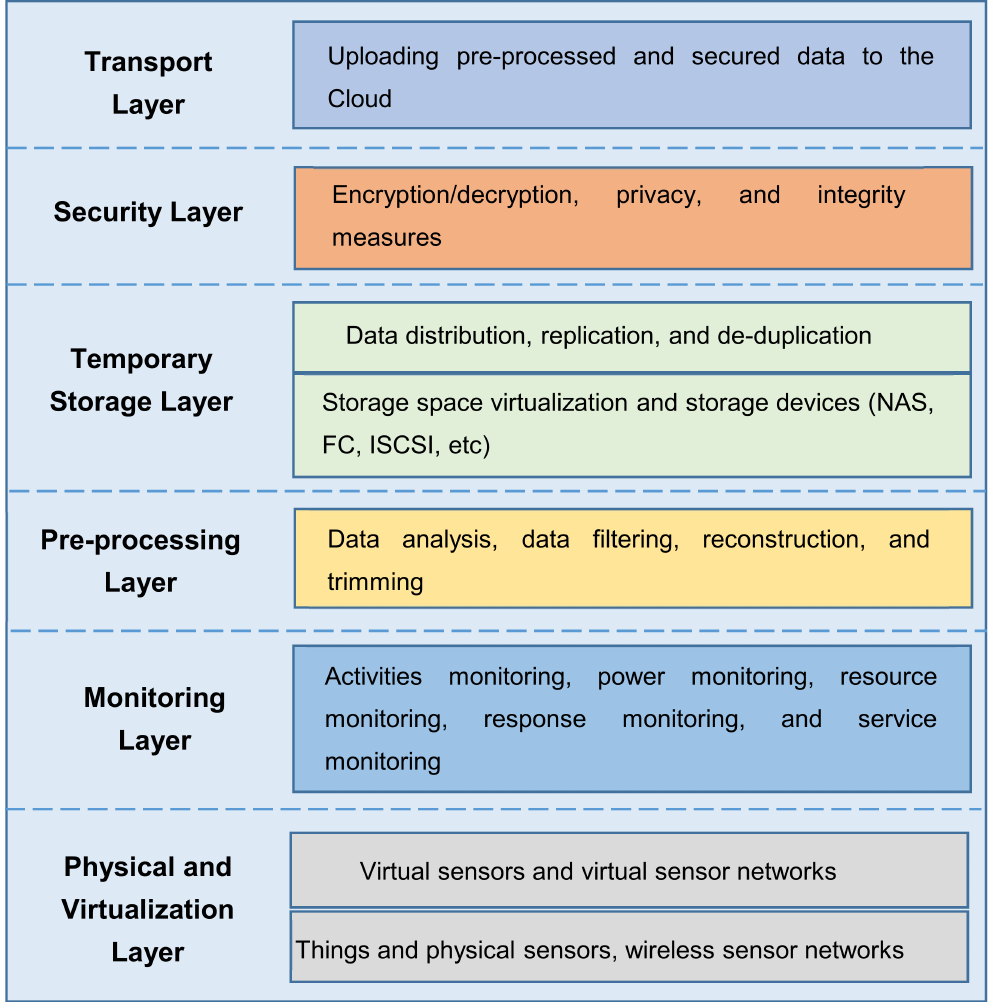
Figure 2. Layered architecture of fog